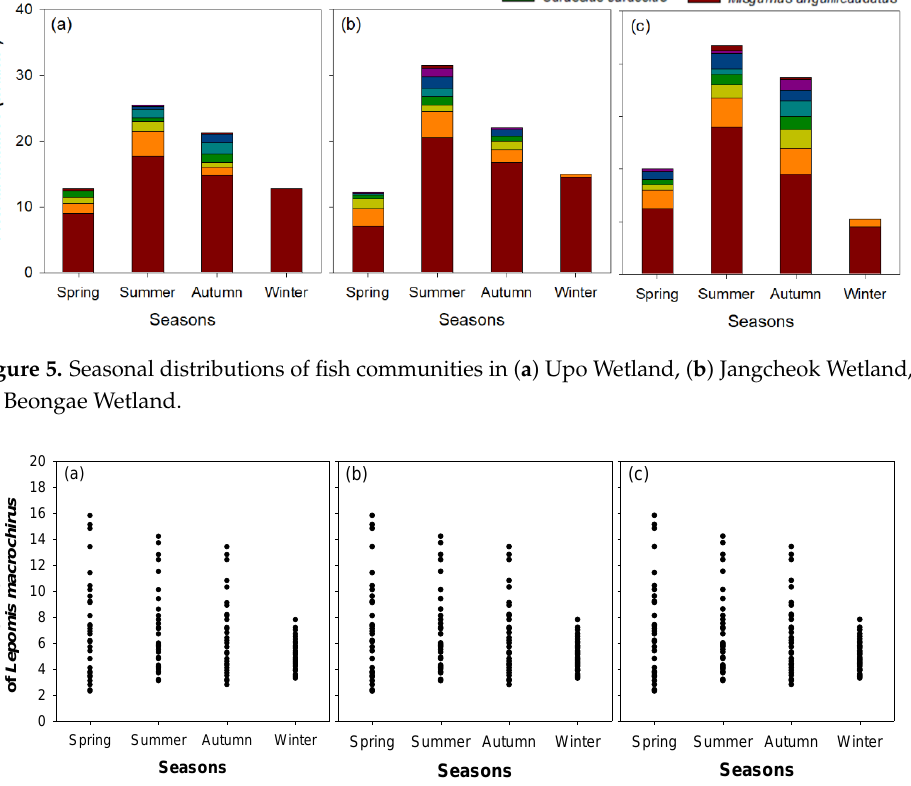
Figure 6. Seasonal body lengths of Lepomis macrochirus in ( a ) Upo Wetland, ( b ) Jangcheok Wetland, and ( c ) Beongae Wetland.